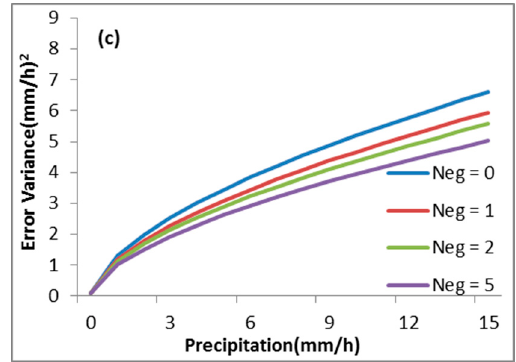
Figure 10. Simulated error variances changing with the precipitation and the gauge network density at the three grid resolutions of ( a ) 0.05°, ( b ) 0.10° and ( c ) 0.25°.